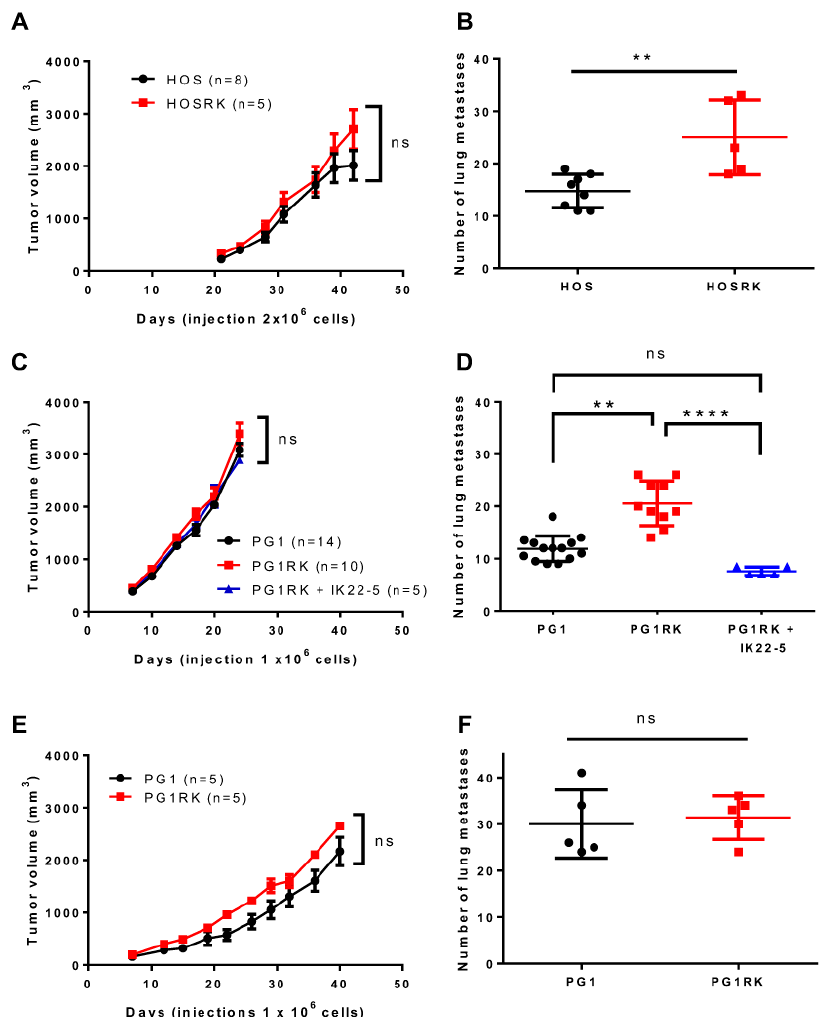
Figure 1. Impact of Receptor Activator of Nuclear factor κ B (RANK) over-expression in osteosarcoma cells on tumor growth and the number of lung metastases. No significant difference was observed concerning tumor growth regardless of the cell-line considered (K-HOS ( A ), MOS-J PG1 ( C , E )) or the immune status of the host mouse strain (Nude ( A , C ) or C57BL/6 ( E )). However, regarding the number of lung metastases, a significant increase was observed regardless of the RANK over-expressing cell-line considered, in immune-deficient Nude mice ( B , D ) but not in immune-competent C57BL/6 mice ( F ). Moreover, injections of a Receptor Activator of Nuclear factor κ B Ligand (RANKL)-blocking antibody (IK22.5) in Nude mice made it possible to reduce the number of lung metastases obtained with RANK expressing PG1 ( D ). n: number of mice in each group. Growth curves ( A , C , E ) are shown as the mean ± SEM. All data analysis was performed with the Kruskal Wallis test. ns: not significant; **: p < 0.01; ****: p <